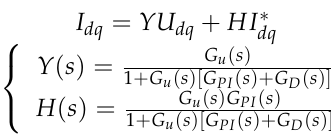
Figure 5. Proposed feedback control strategy. ( a ) Fundamental droop control; ( b ) feed-forward of instantaneous grid fre- quency and voltage magnitude; ( c ) instantaneous frequency detection method; ( d ) incomplete differential control; ( e ) co- ordinate transformation; ( f ) active and reactive power calculation with inter-harmonics.